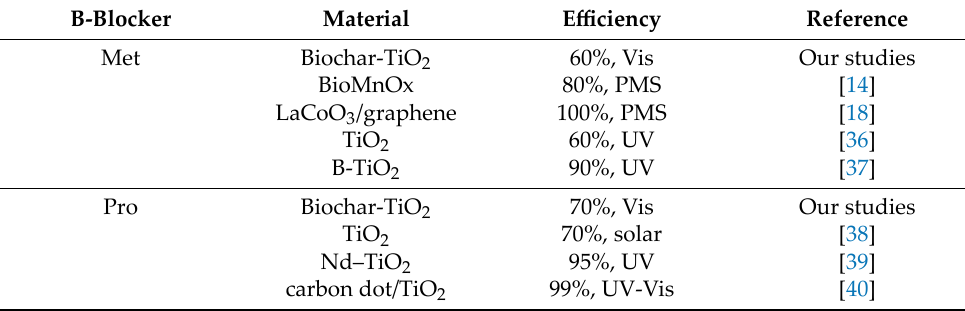
Table 2. Comparison of the obtained results with the literature